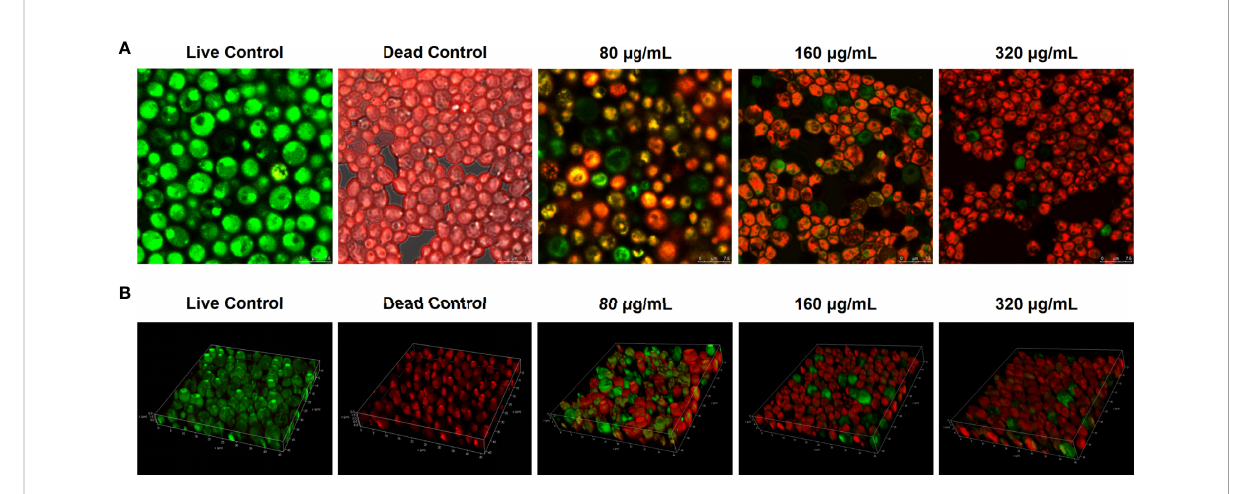
(Figure 4D). When the magnolol concentration was 160 and 320 m g/mL, the content of C. albicans cell wall b -glucan was only 1.197 and 1.165 m g/mL, respectively. The results above implied that magnolol could inhibit the virulence of C. albicans by disrupting its cell wall integrity and impeding the synthesis of cell wall b